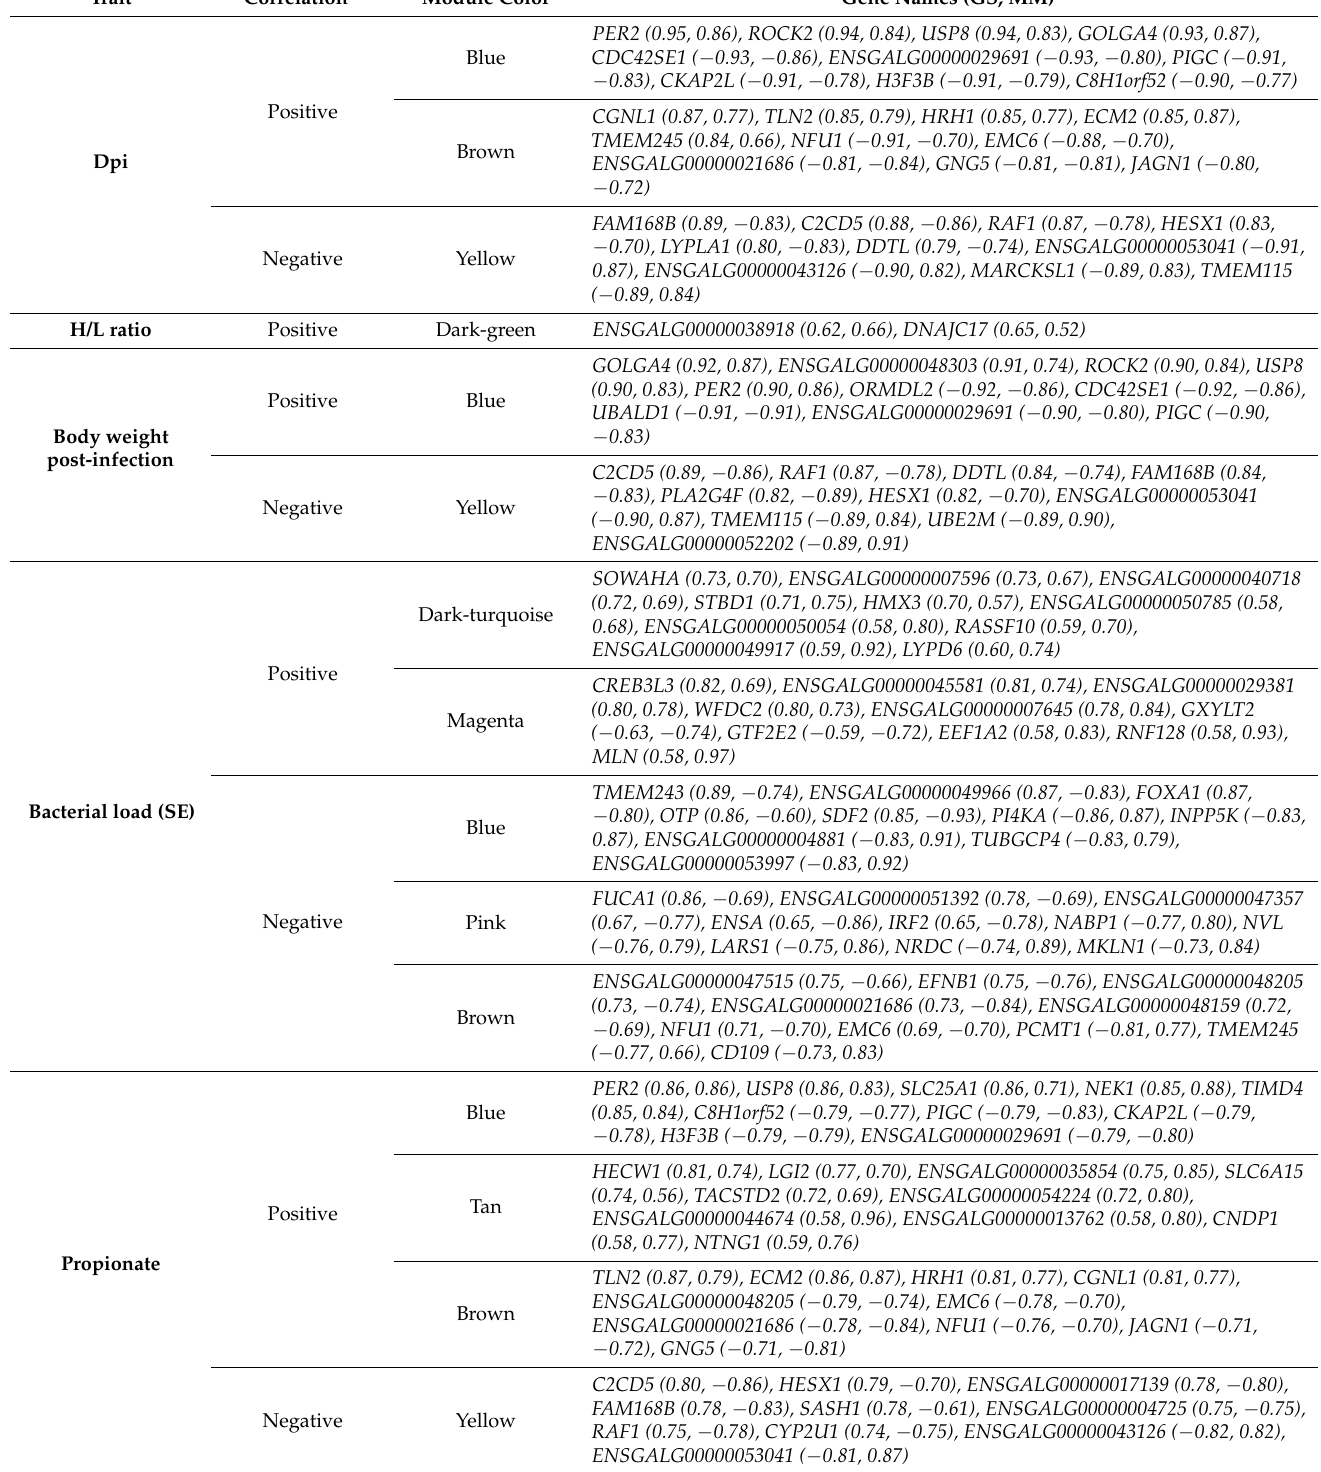
Table 2. Table 2. Top ten driver genes in the significant